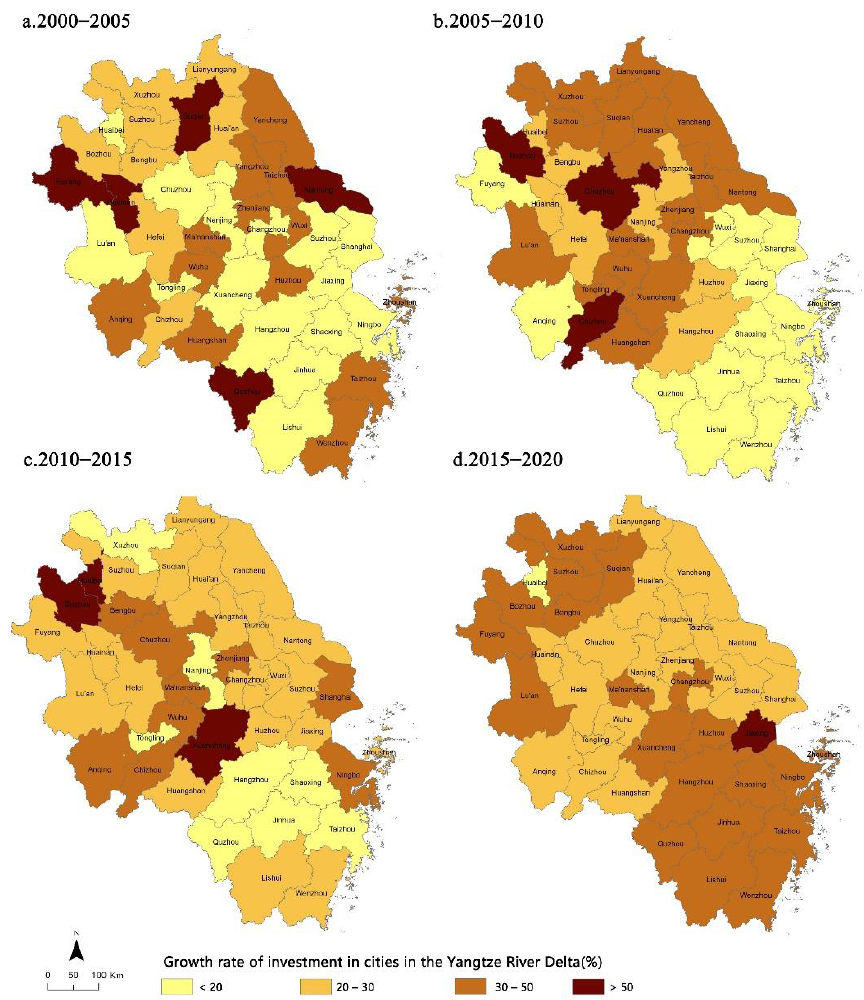
Figure 5. The investment growth rate of cities in the YRD during 2000 – 2020.